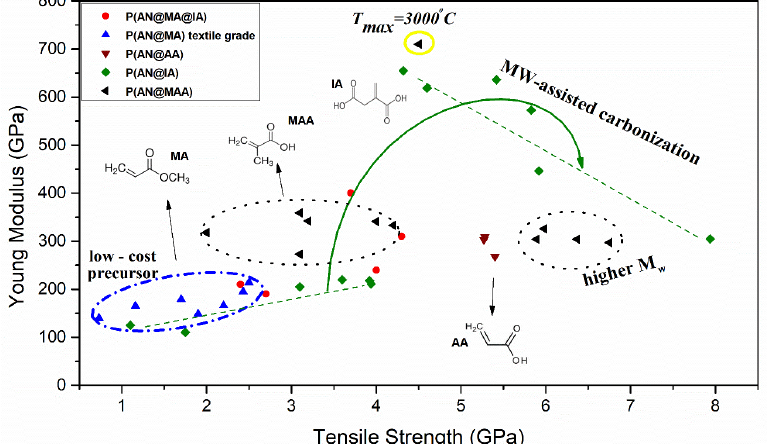
Figure 4. Carbon fiber (CF) performance dependence on chemical composition based on literature data presented in Figure 3.